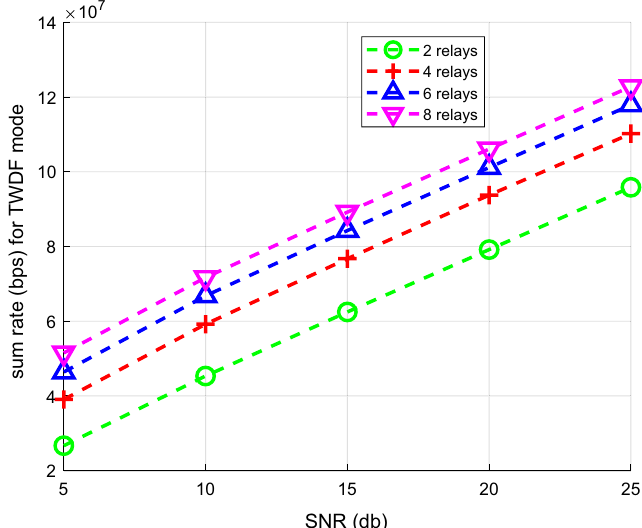
Fig. 7 Sum-rate curves in DF relaying. It is the sum-rate curve with different number of relays, and the transmit SNR is from 5 to 25 db in DF